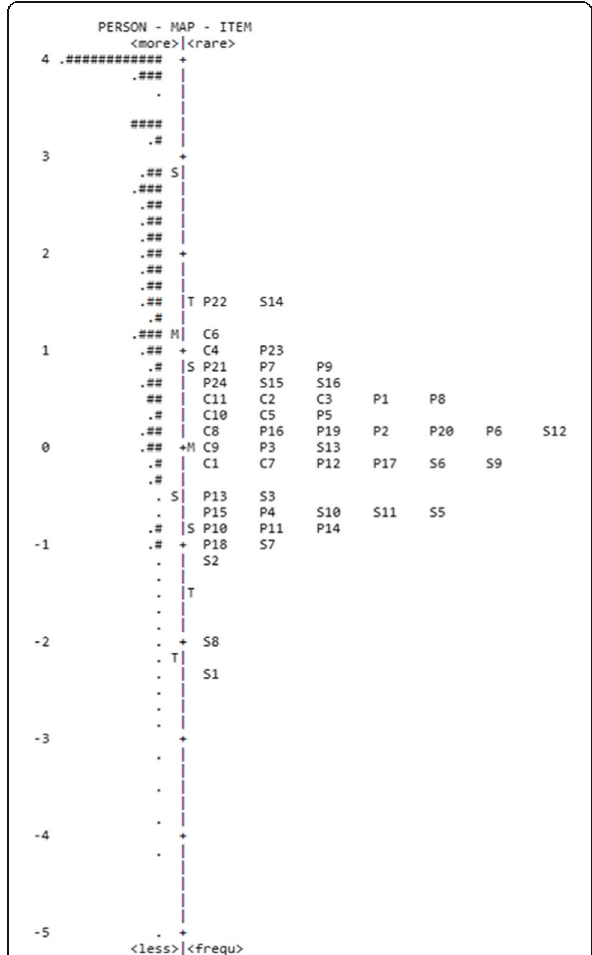
Fig. 2 EFA-DI ’ s item-person map. M, mean; S, 1st standard deviation; T, 2nd standard deviation; number sign indicates group of seven people; full spot indicates group of six